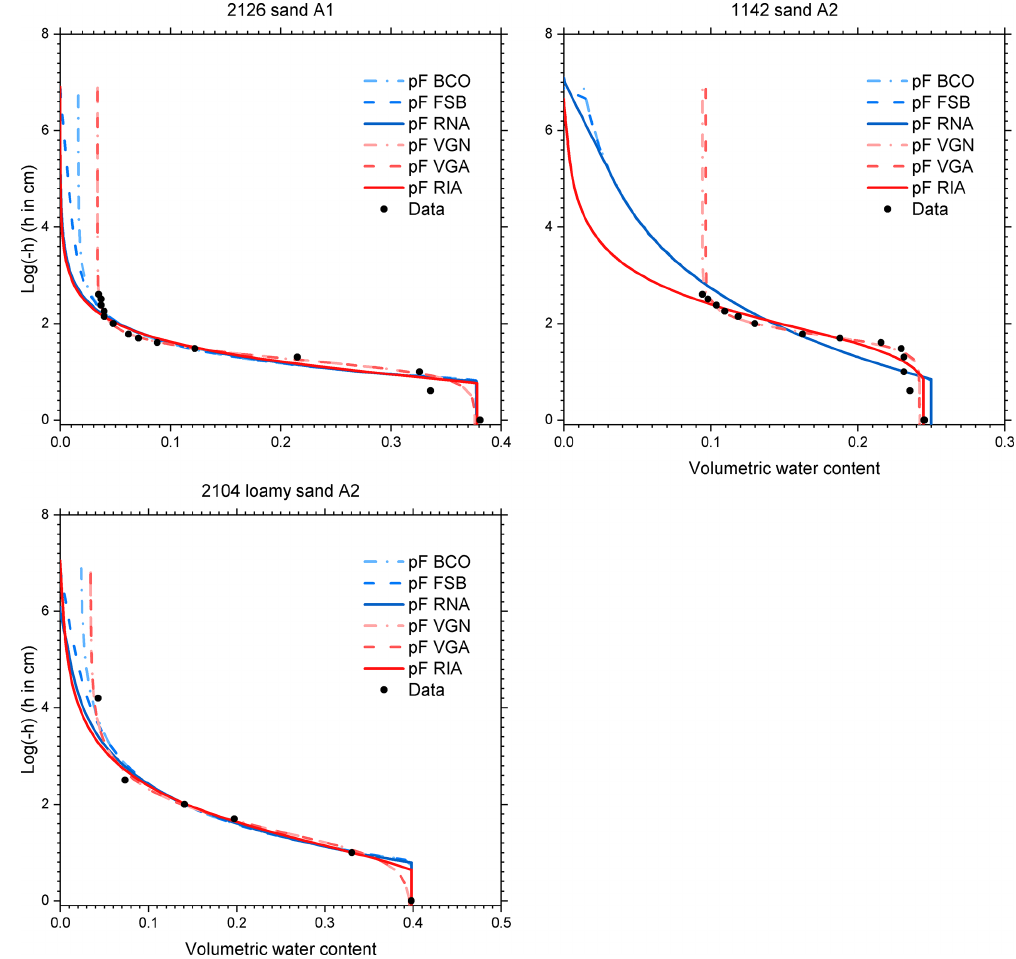
Figure C2. Retention data and fitted soil water retention curves according to six parameterizations for selected UNSODA soils with the A1 or A2 classification of Twarakavi et al. (2010). The parameterizations are explained in the